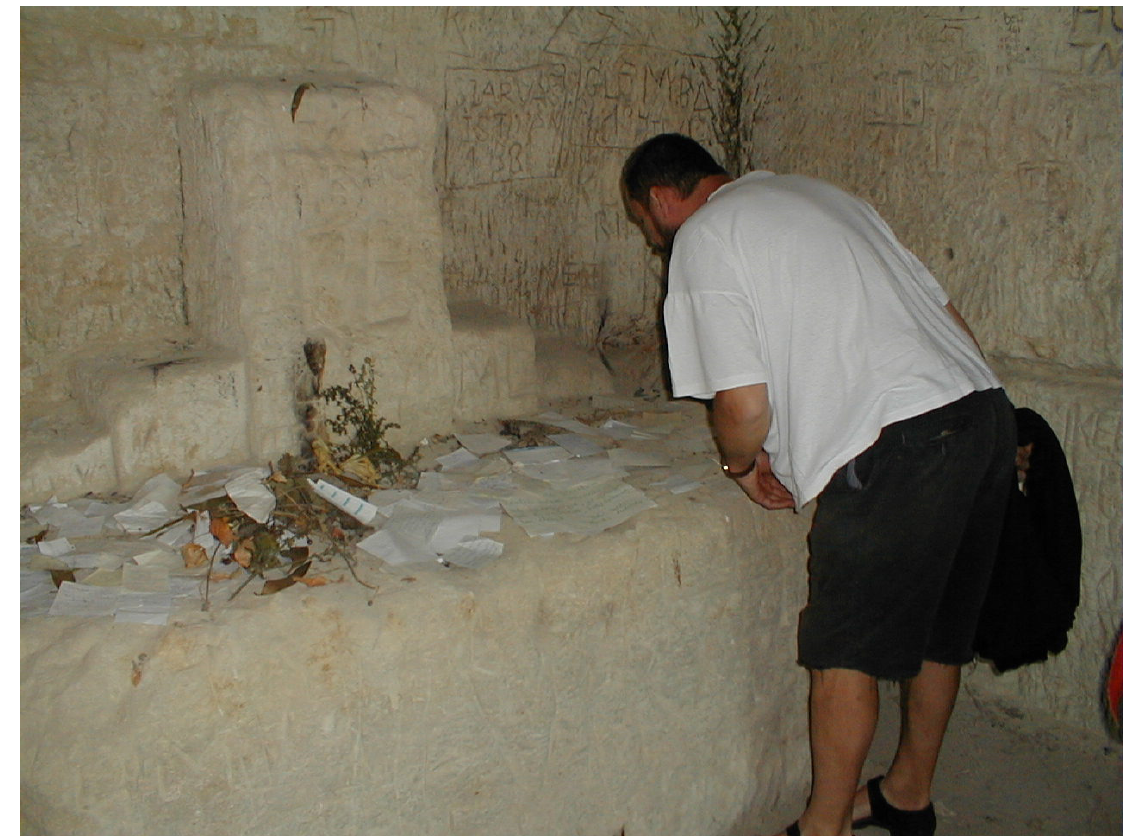
Figure 3. The hermit’s cave in Mátraverebély-Szentkút,Photo taken by Gábor Magyar,